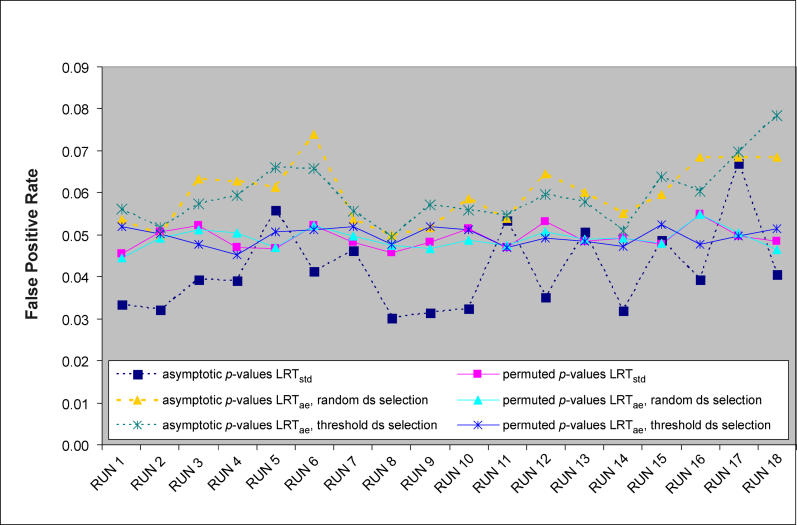
Line Graph Illustrating Estimates of the False-Positive Rate at the 0.05 Significance Level for LRTstd and LRTae
The p-values were determined by both permutation and the asymptotic central χ2 distribution. The 18 runs correspond to the combinations of parameter settings described in Table 1. For all 18 runs, LRTae was computed with the random and threshold double-sample selection methods. When the threshold double-sample method was used to compute LRTae, the setting of δ = 0.85 was used, and the maximum proportion of individuals included in the double sample was the value for α specified by the fractional factorial design. SNPHAP v 1.3.1 was used for the haplotype inference for the simulation results displayed in the graph.